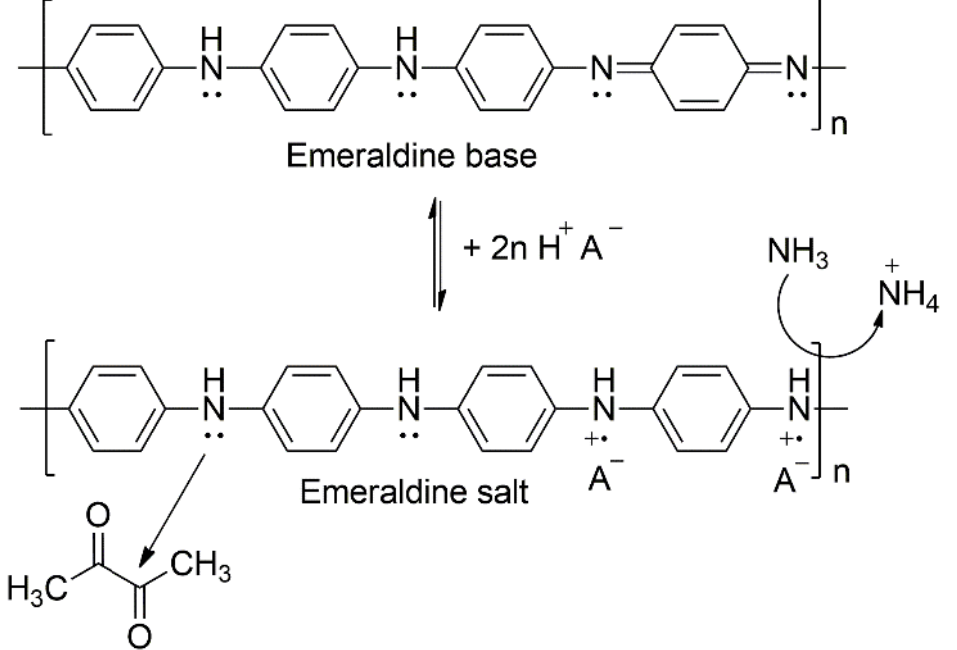
Figure 7. Chemical structures of the emeraldine base ( top ) and the protonated salt form ( bottom ). Possible interaction of the PANI nitrogen with butane-2,3-dione and ammonia are shown.